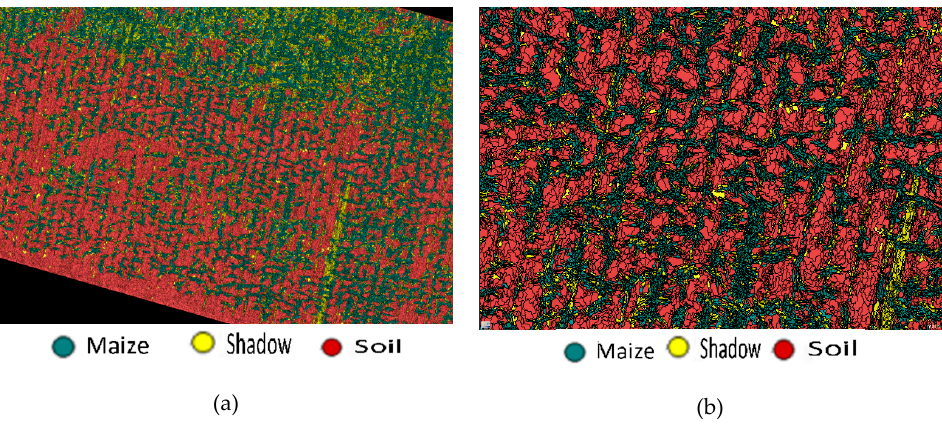
Figure 2. Segmentation and classification of objects present in the orthomosaics for the extraction of pixels belonging to and classified as corn plants: ( a ) and ( b ) processing and analysis of the crop image based on objects for three classes: corn, shadow, and soil.